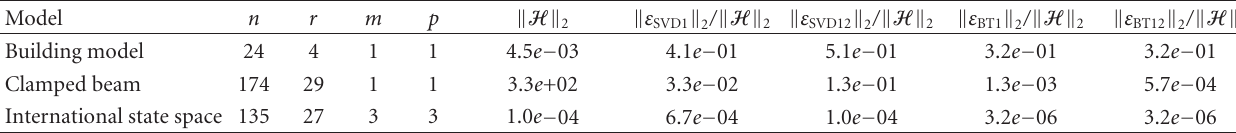
Table 1: Errors of reduced models produced by four di ff erent methods.